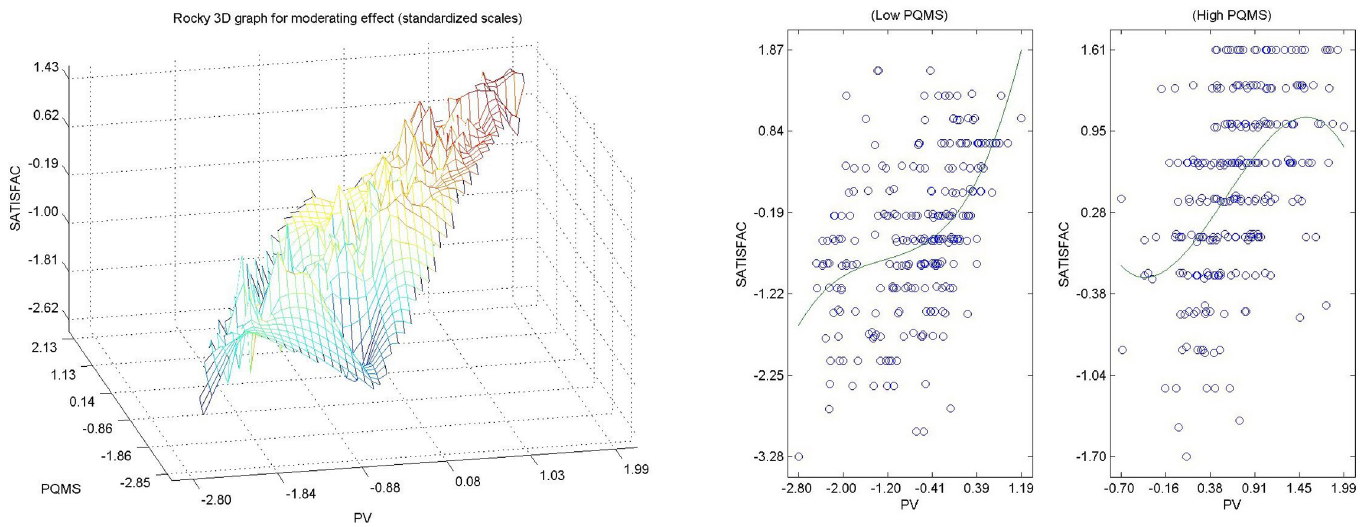
Fig 10. a. Hypothesis 8 3D, PQMS- > PV- SATISFAC. b. Hypothesis 8 2D, PQMS- > PV- SATISFAC.